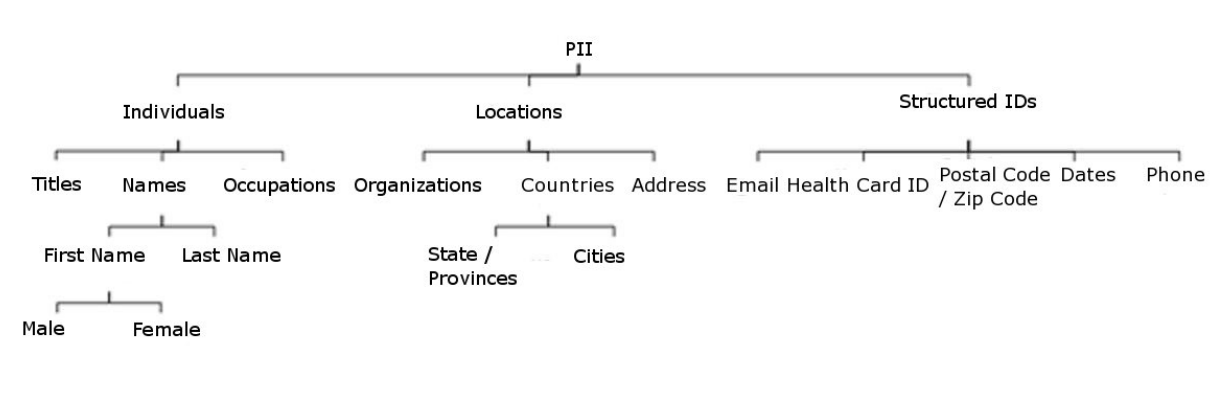
Figure 2. Personally identifiable information (PII) categories and their subcategories. ID =